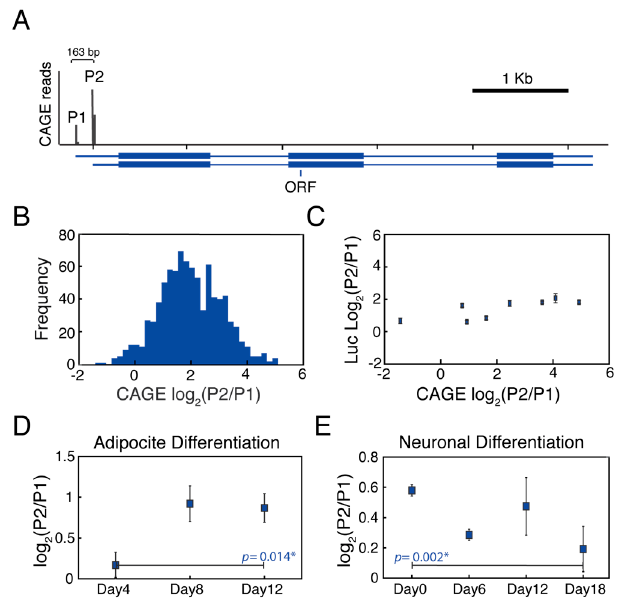
Figure 1. MYC transcription is driven by two alternative promoters which are differentially regulated in vivo. ( A ) Cap analysis of gene expression (CAGE) reads show that MYC gene is expressed by two alternative promoters, P1 and P2; ( B ) Histogram of promoter usage ratio across 869 samples obtained from the FANTOM5 database; ( C ) In vivo promoter usage ratio cannot be explained by promoter activity alone; ( D ) Adipocyte differentiation leads to stronger usage of the P2 promoter; ( E ) Neuronal differentiation leads to stronger usage of the P1 promoter. ORF: open reading frames. Error bars represent standard error of mean.